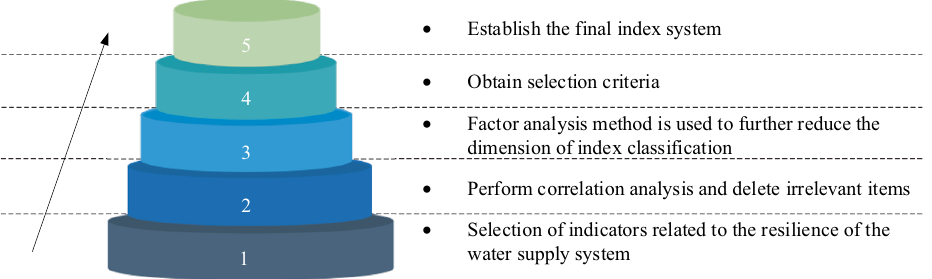
Figure 5. Selection model of toughness index of urban water supply system (according to the arrow direction, from bottom to top, show the establishment process of toughness index selection model of the urban water supply system).